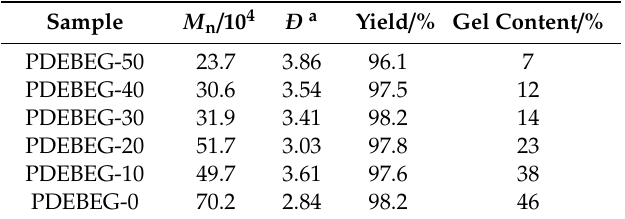
Table 3. Molecular weight, yield, and composition of redox-initiated PDEBEG.